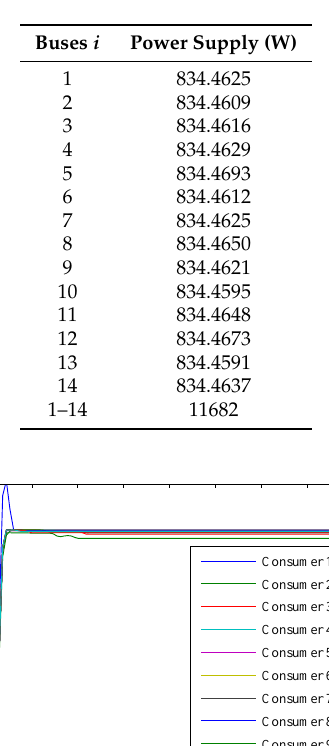
Table 7. The power supply on each bus in IEEE 14-bus system.